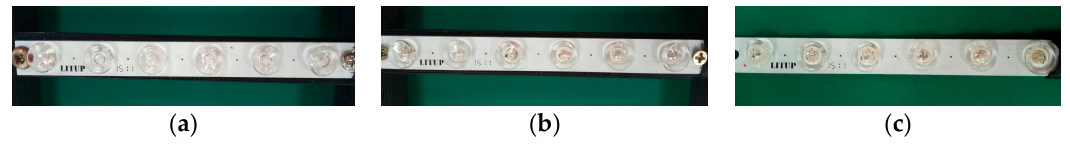
Figure 5. ( a ) SFL mechanical drawing; ( b ) 130° SFL prototype; ( c ) 150° SFL prototype; ( d ) 170° SFL prototype. Figure 6. New mosquito trap UV_LED light bar module: ( a ) lighting of 130° angle, ( b ) lighting of 150° angle, ( c ) lighting of 170° angle.